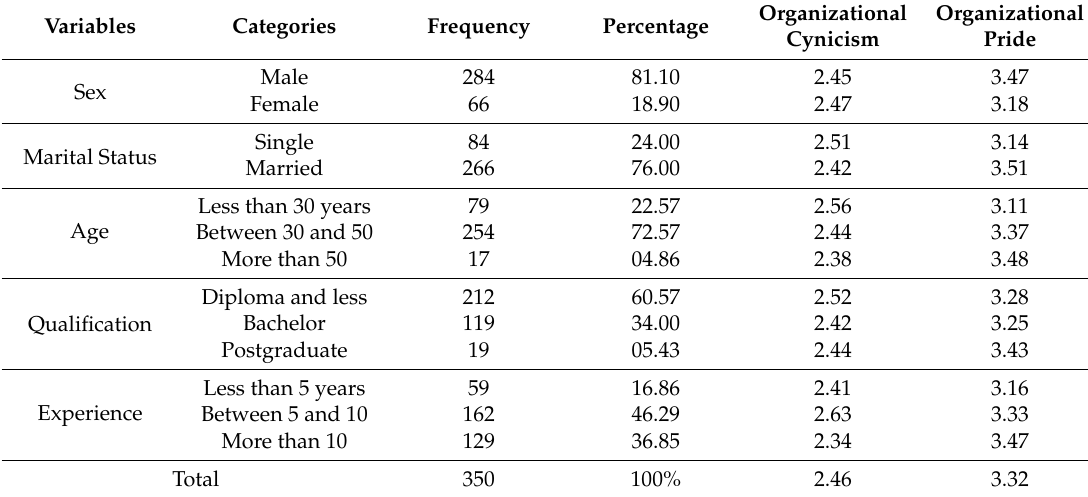
Table 2. Demographic data